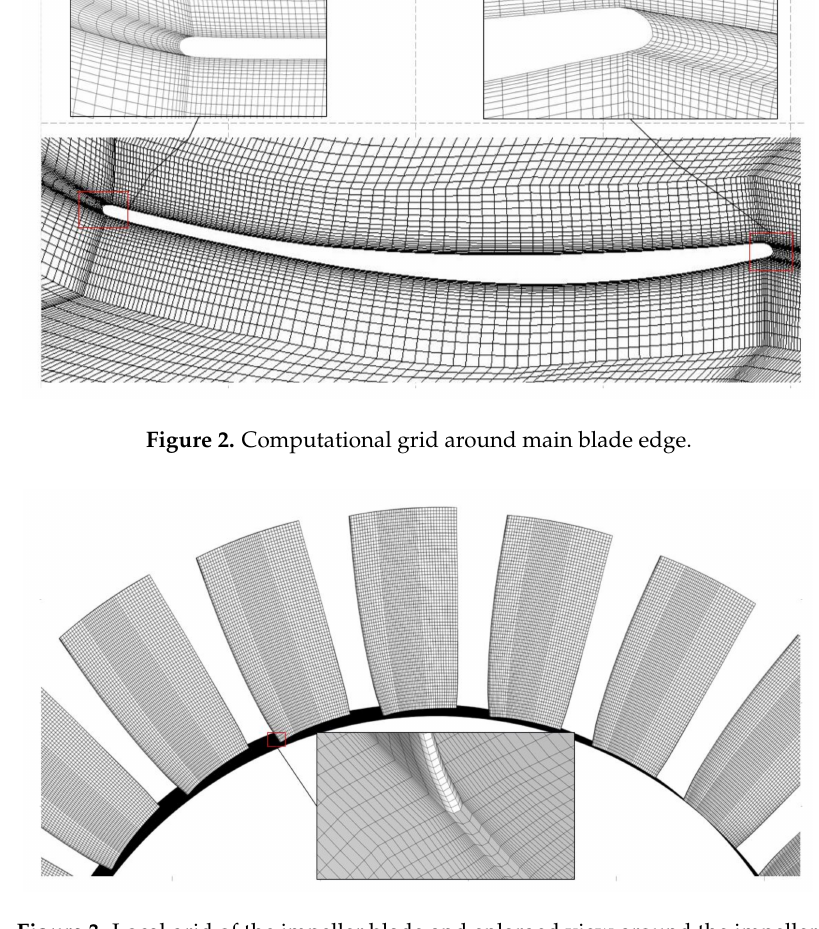
Figure 3. Local grid of the impeller blade and enlarged view around the